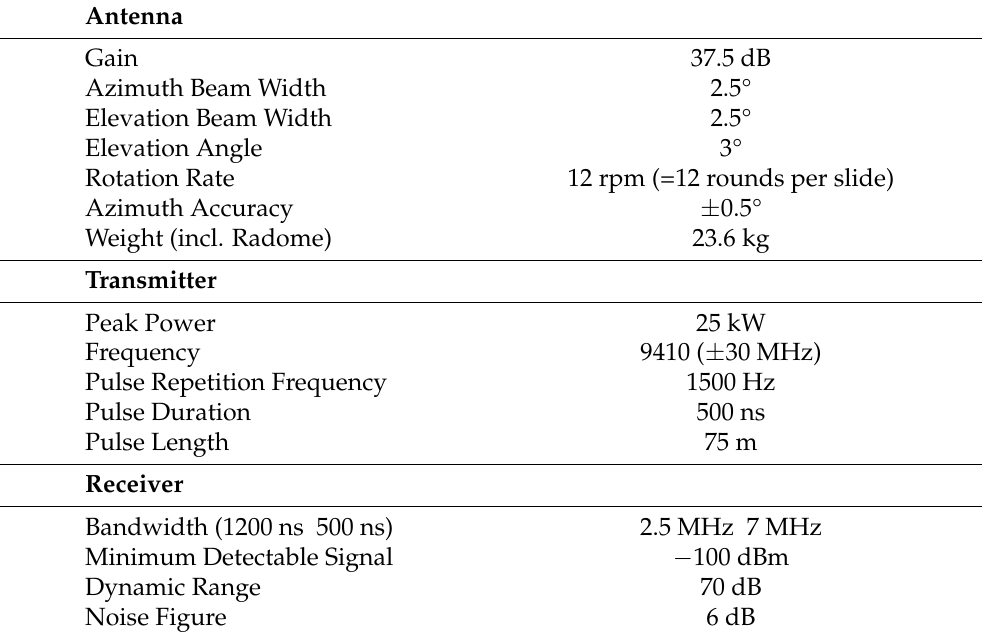
Table 1. Technical details about the X-Band radar radar at Kirnberg (Geigersau farm, Weilheim- Schongau, Bavaria,